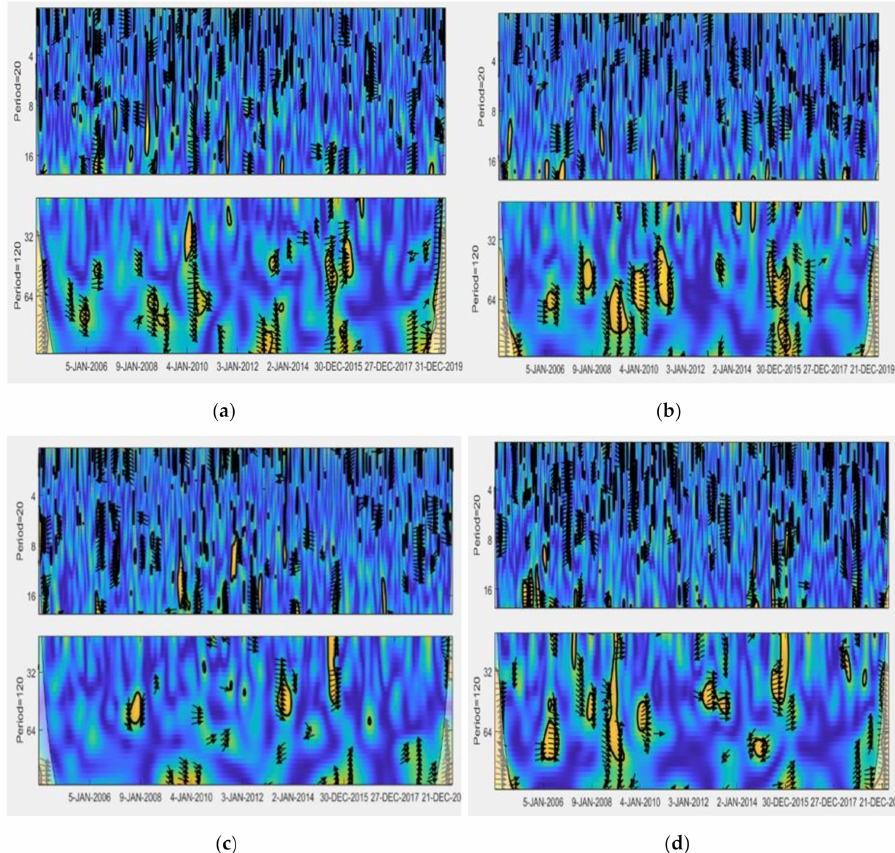
Figure 3. The long-term and short-term wavelet coherence diagrams of crude oil price fluctuation and stock markets: ( a ) US stock market, SP500; ( b ) Japanese stock market, N225; ( c ) mainland China’s stock market, SSEC; ( d ) Hong Kong stock market,